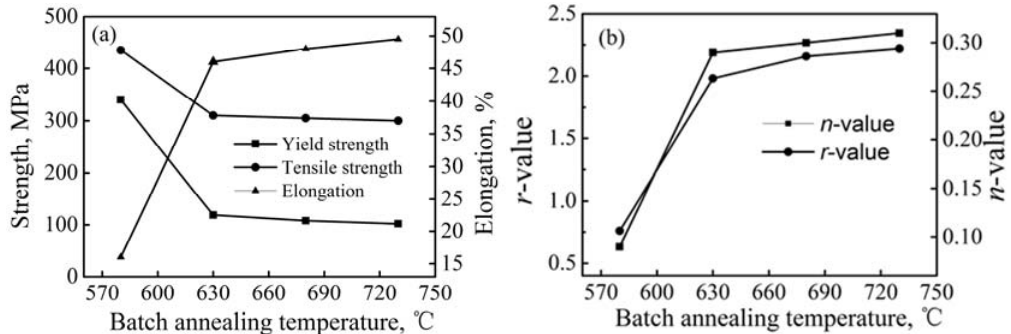
Figure 7. Relationship between the mechanical properties and batch annealing temperature of ultra-low carbon enamel steel. ( a ) Strength and Elongtation. ( b ) n and r value